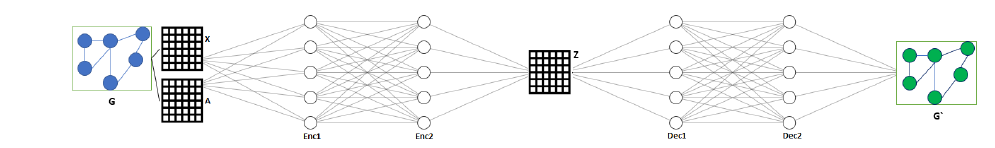
Figure A3. An example of a graph autoencoder